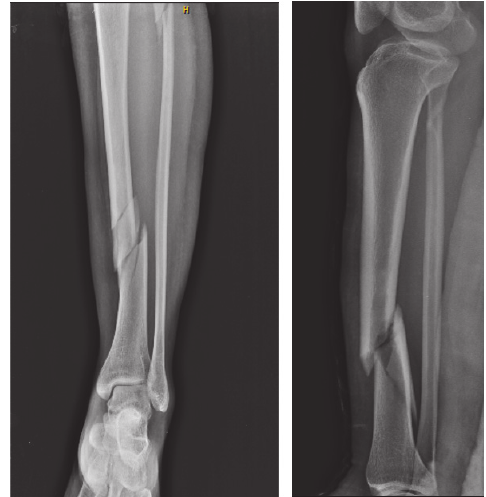
Figure 1: Radiographs showing the anteroposterior and lateral views of tibial shaft fracture.